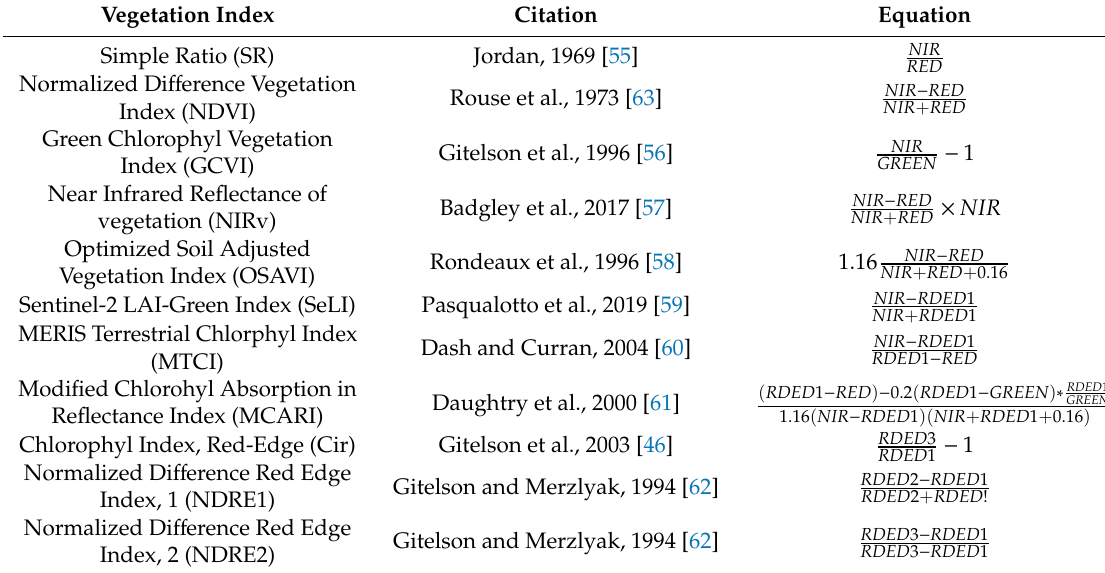
Table 3. Vegetation Indices. All vegetation indices tested, source for their derivation, and equation (RDED = red edge). Sentinel-2 analyses tested all vegetation indices. Landsat analyses tested GCVI.